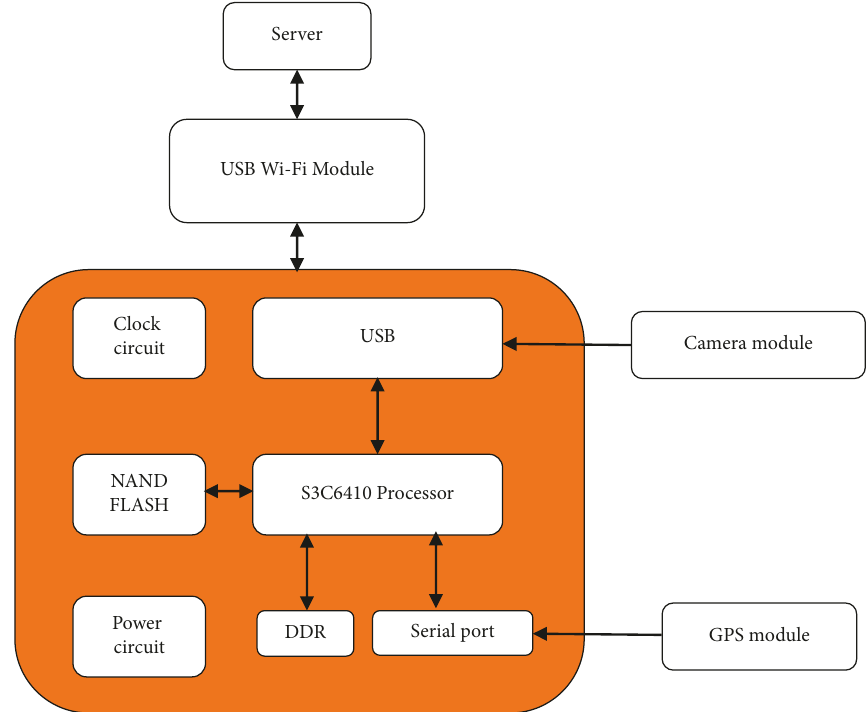
Figure 3: Hardware structure diagram of video image collection and transmission module.